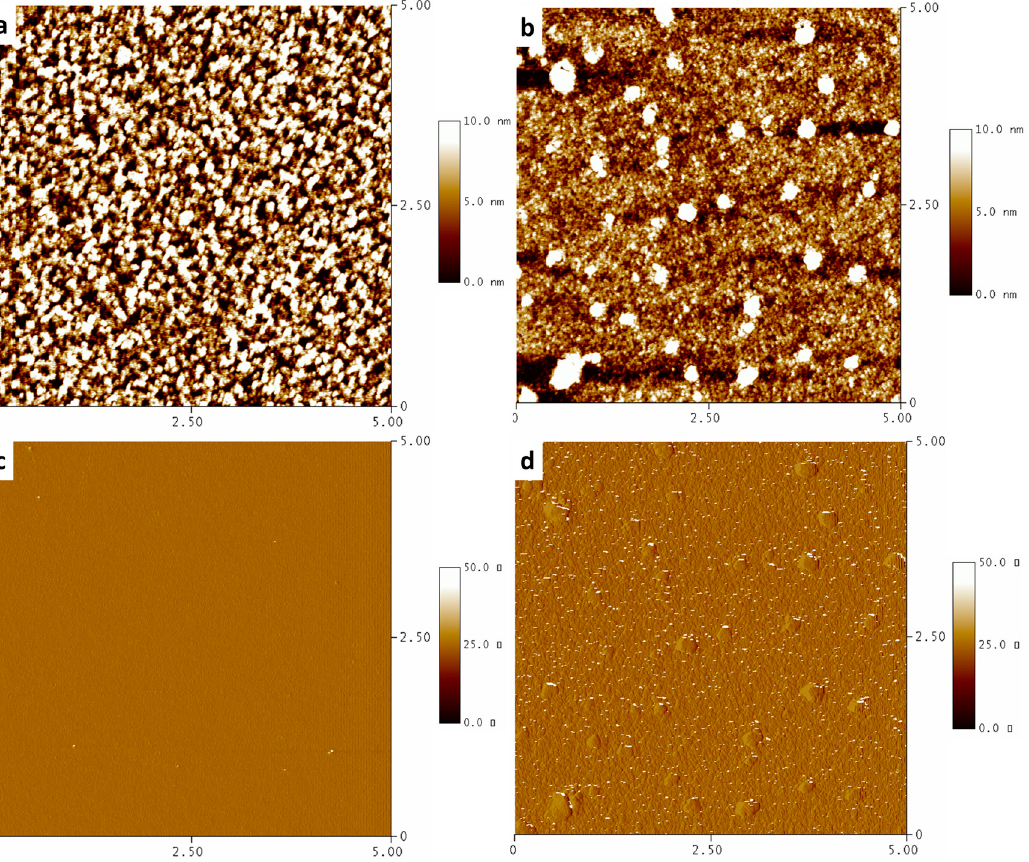
Figure 6. AFM topography images (5 μ m × 5 μ m) of ( a ) PTPACF :PC 71 BM blend film and ( b ) PTPA2CF :PC 71 BM blend film; AFM phase images of ( c ) PTPACF :PC 71 BM blend film and ( d ) PTPA2CF :PC 71 BM blend film.